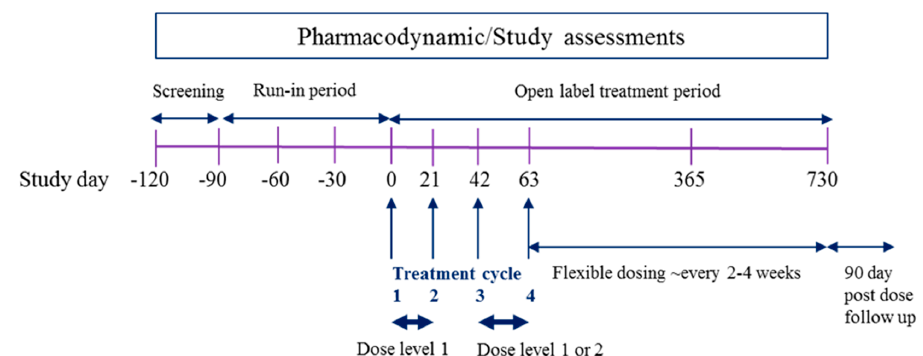
Table 1. Characteristics of